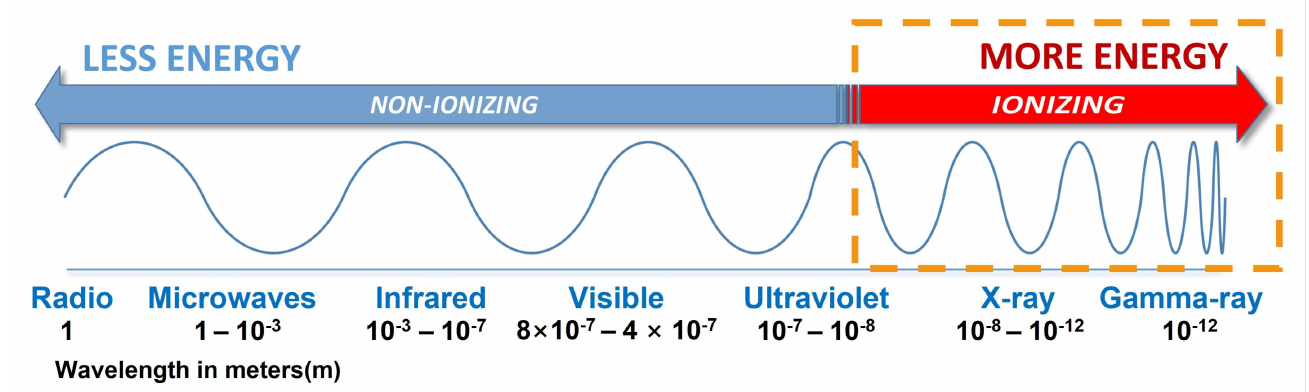
Figure 1. Ionizing and non-ionizing electromagnetic